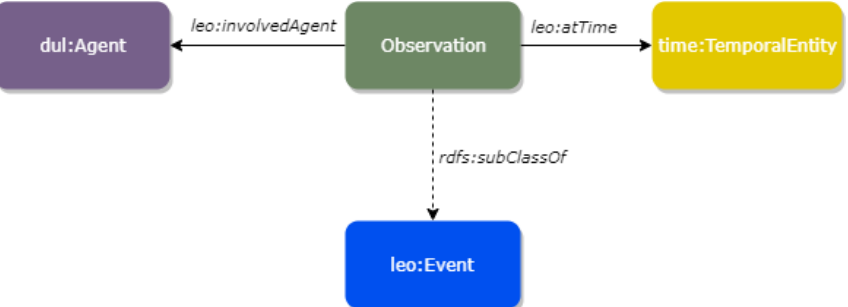
Figure 2. Upper-level domain ontologies for observations.